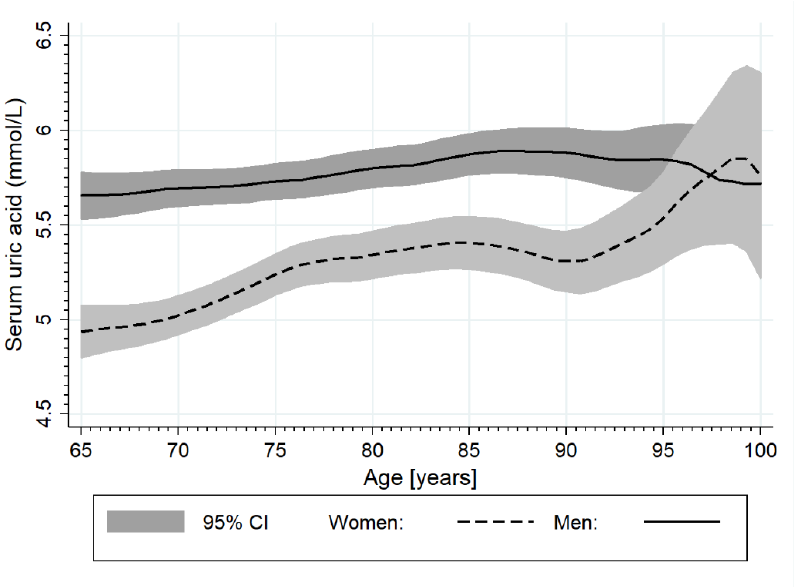
Figure 2. The relationship between serum uric acid (SUA) levels and age in men and women separately. Hyperuricemia, as defined by SUA ≥ 6 mg/dL in women and ≥ 6.8 mg/dL in men, was observed in 544 (28.2%) women and in 520 (24.7%) men ( p < 0.05). The weighted prevalence of hyperuricemia for the Polish population was estimated at 23.1% (95% CI: 21.8–24.4), being higher among women (25.5%; 23.4–27.4) than men (19.2%; 17.5–20.9). Only 62 (11.9%) men and 37 (6.8%) women with hyperuricemia were treated with allopurinol ( p < 0.01). There was an increase in the frequency of hyperuricemia with age, both in men and women (Figure 3) from 22.3% in men and 19.9% in women aged 65–69 years to 30.6% and 34.0% aged 90 years or above, respectively. When applying the same SUA cut-off (>6 mg/dL) for the definition of hyperuricemia in both sexes, the observed frequency would be much higher in men (N = 846; 40.3%) than in women (N = 544; 28.2%; p <